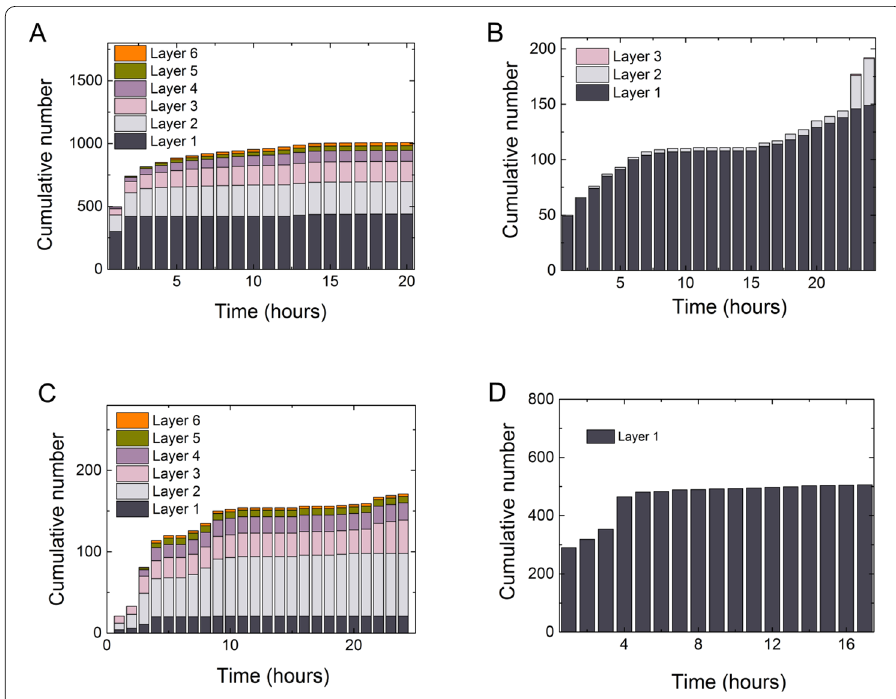
Figure 2 Different layer sizes as a function of time in typical networks. The y axis is the cumulative number of re-postings at different layers of typical networks in Weibo and Twitter. The x axis is the time (in hours) from the time of news creation and the different colors stand for different layers. Shown examples are ( A ) fake news and ( B ) real news in Weibo, as well as ( C ) fake news and ( D ) real news on Twitter. These four typical networks are the same networks shown in Fig. 1. In Fig. 2A, the fraction of nodes located in the first layer is around 45% of all the nodes at the end of propagation. However, in Fig. 2B, the total number of nodes in the first layer occupies about 78% of all the nodes at the end of propagation. If the total number of nodes does not change much after 20 hours, we ignore the re-posting after 20 hours in order to clearly see the layers in the figure. It is seen that the layer sizes of real news and fake news are significantly different in both Weibo and Twitter. Real news networks tend to have a relatively larger first layer, while fake news networks are relatively uniformly distributed in different